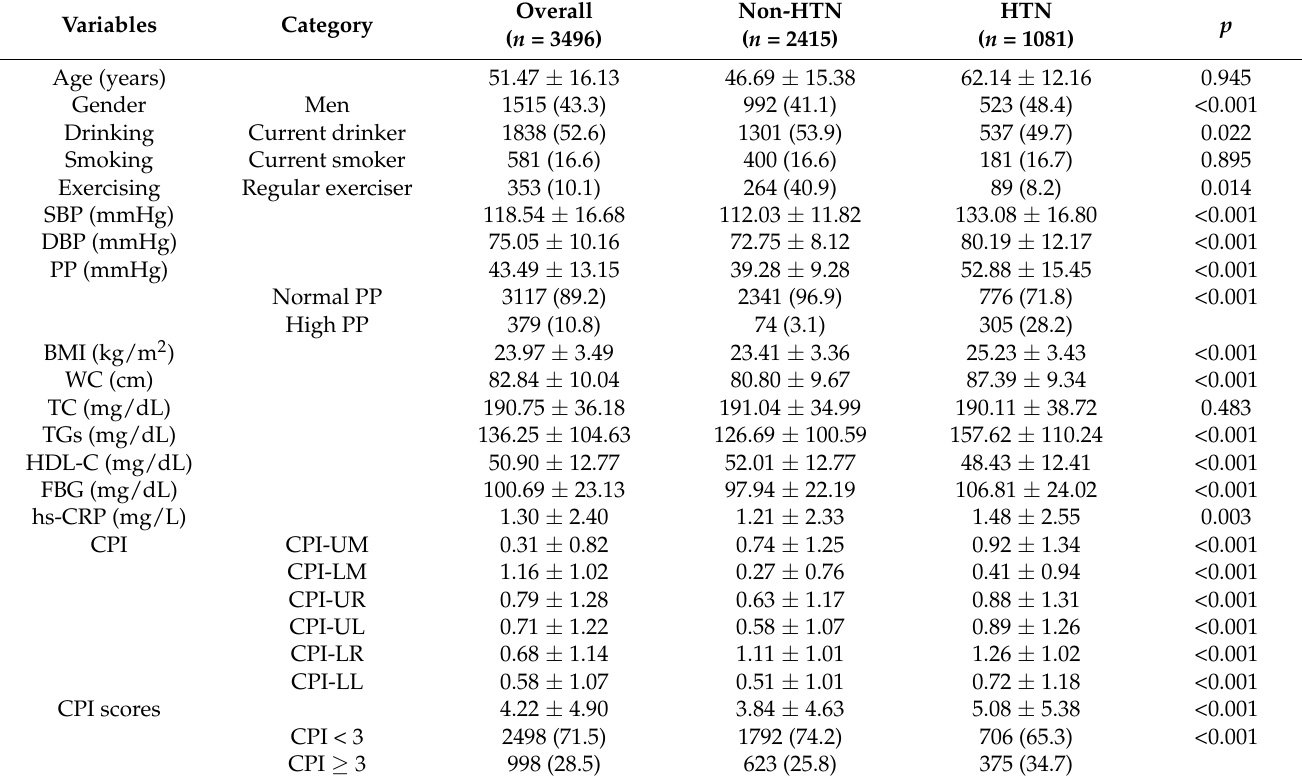
Table 1. General clinical characteristics. n (%), Mean ±